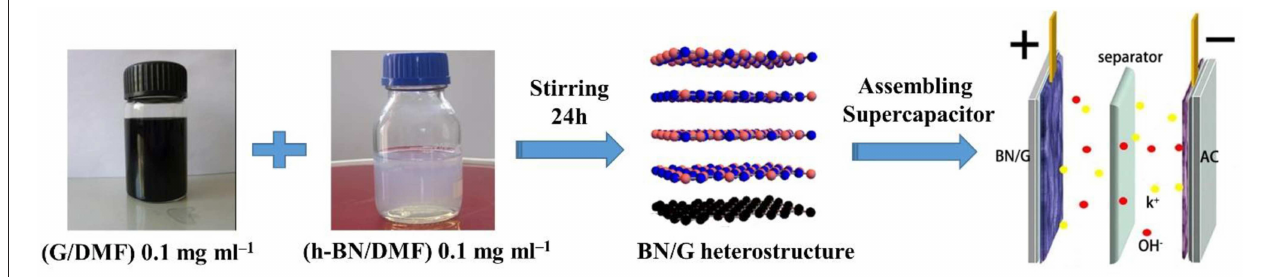
FIGURE 1 | Schematic illustration for the preparation of the BN/G heterostructure.